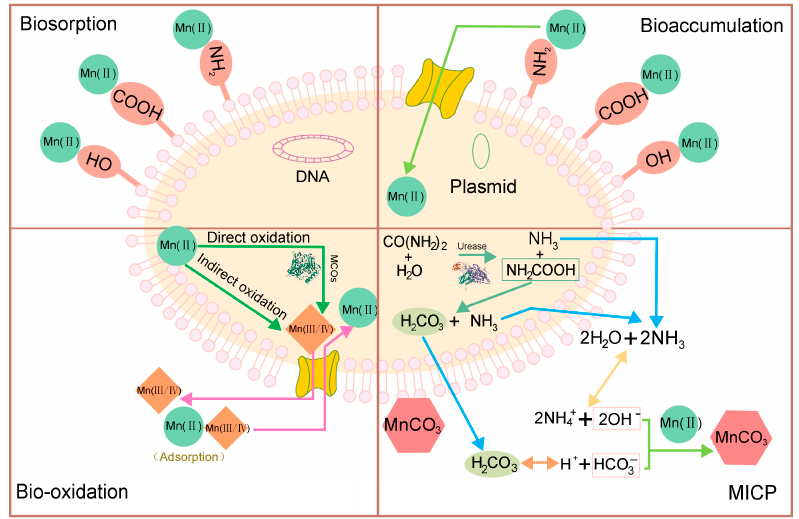
Figure 2. Illustration of four main biological treatments for Mn removal (where three − dimensional structures of a kind of MCOs and urease are presented). Reprinted with permission from Refs. [140,141].